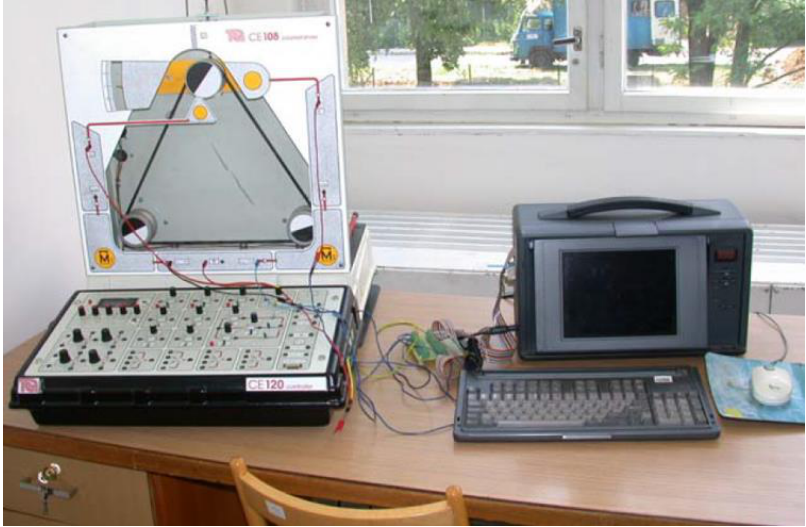
Figure 9. Photo of CE108 Coupled Drives Apparatus model connected with PC with MATLAB.